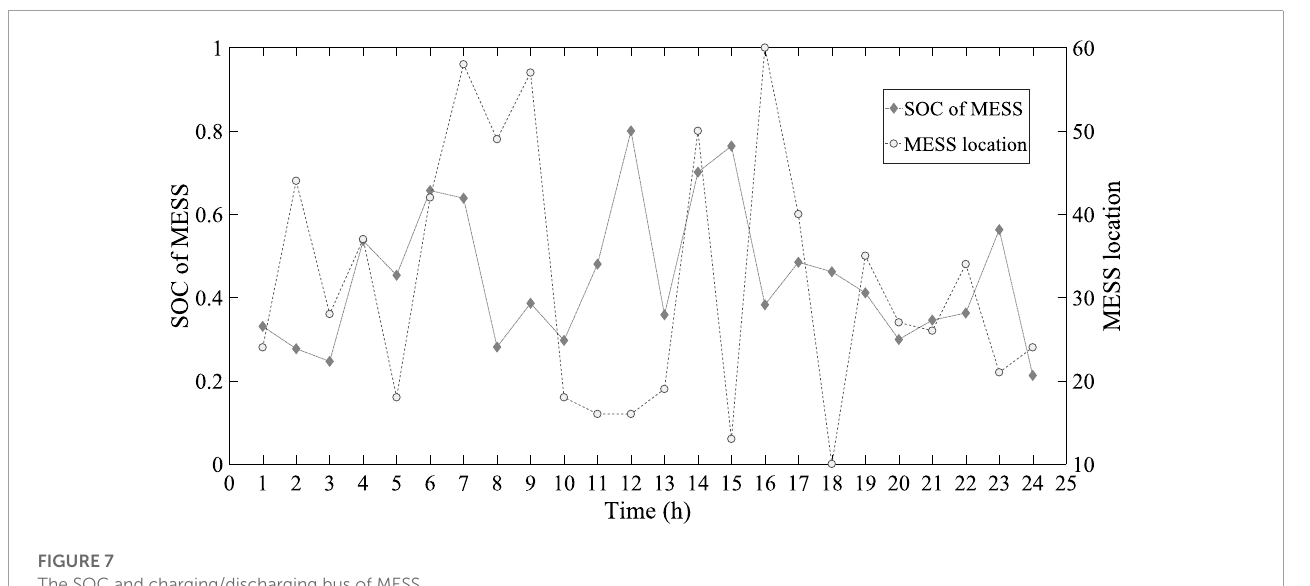
FIGURE 7 The SOC and charging/discharging bus of MESS.